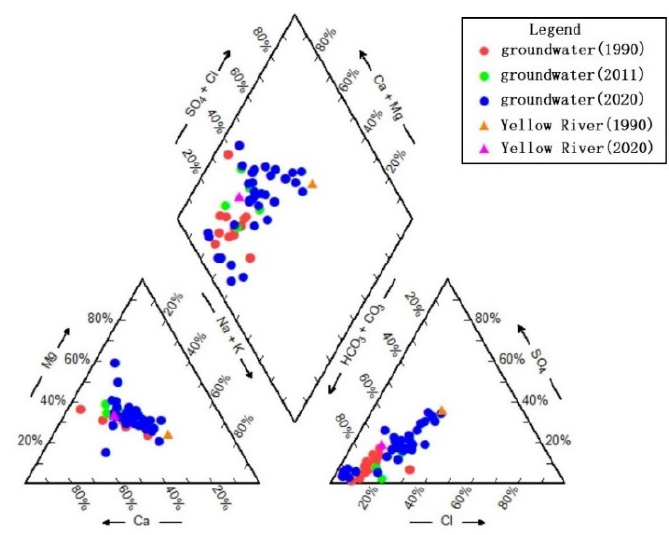
Figure 7. Piper map of groundwater in the study area.